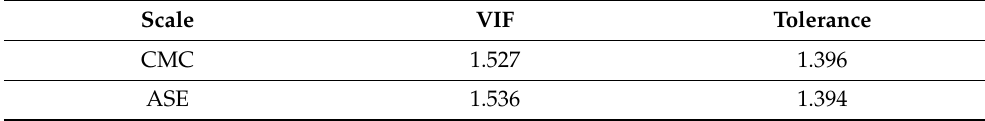
Table 3. VIF and Tolerance values of the arguments.